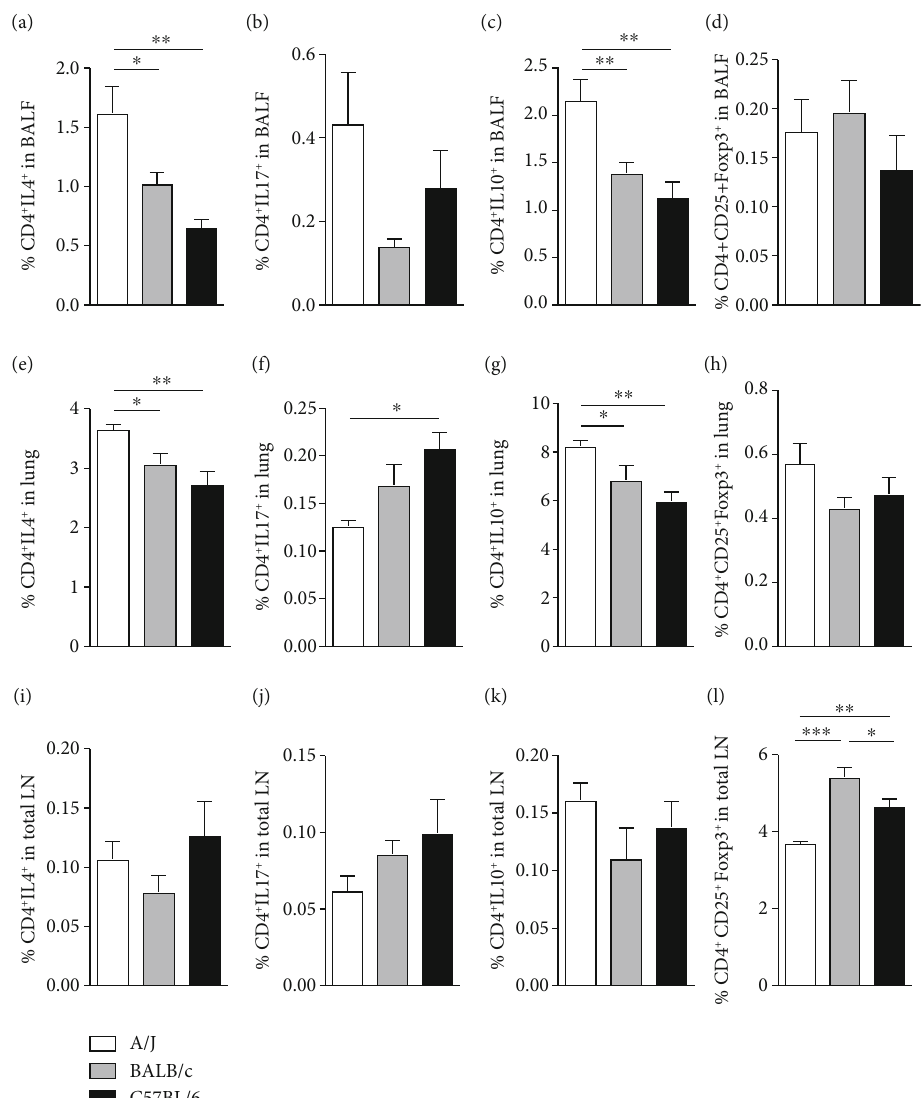
Figure 4: Frequency of Th2, Th17, and regulatory T cells in the airways, lung parenchyma, and lymph nodes of A/J, BALB/c, and C57BL/6 naïve animals. Flow cytometric analysis of CD4 + cells producing IL-4, IL-17, and IL-10, and CD4 + CD25 + Foxp3 + Tregs, respectively, in the BALF (a – d), lung tissue (e – h), and in total lymph nodes (i – l). Values represent mean ± SEM of 4-5 animals per group. ∗ P < 0 : 05 , ∗∗ P < 0 : 01 , ∗∗∗ P < 0 : 001